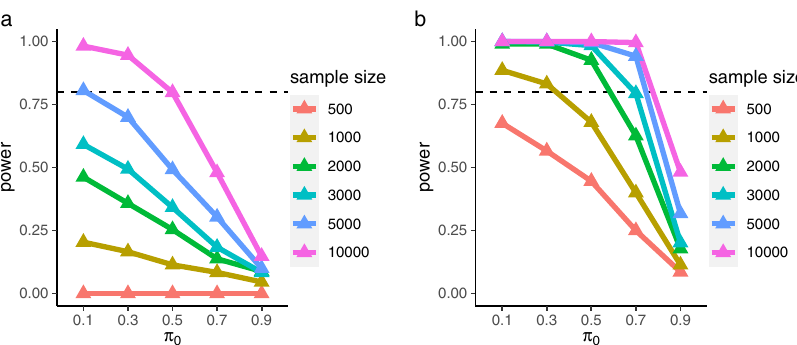
Fig. 4 Power under liability-threshold model. The proportion of noncausal common variants π 0 (0.1 – 0.9) in the common-variant polygenic component was considered in power estimation. For the other parameters, two different combinations were applied. We simulated a “ low ” ( h 2 ¼ 0 : 3 ; h 2 ¼ 0 : 03 ; f ¼ 0 : 005 ; K ¼ 0 : 01) and b “ high “ ( h 2 ¼ 0 : 5 ; h 2 ¼ 0 : 1 ; f ¼ 0 : 05 ; K ¼ 0 : 05) levels to show the effect of π 0 on the power at PB PB LEV LEV different levels. The results under the polygenic genetic architecture are shown. Results for the other two genetic architecture models can be found in Supplementary Fig. 2. Broken line at 80% is a reasonable threshold. Source data are provided as a Source Data fi le.